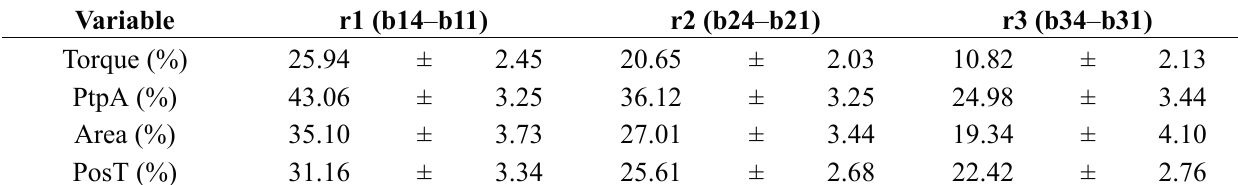
Table 1. Recovery percentage ( mean ± SE ) within first 60s (r1 > r2 > r3, p <